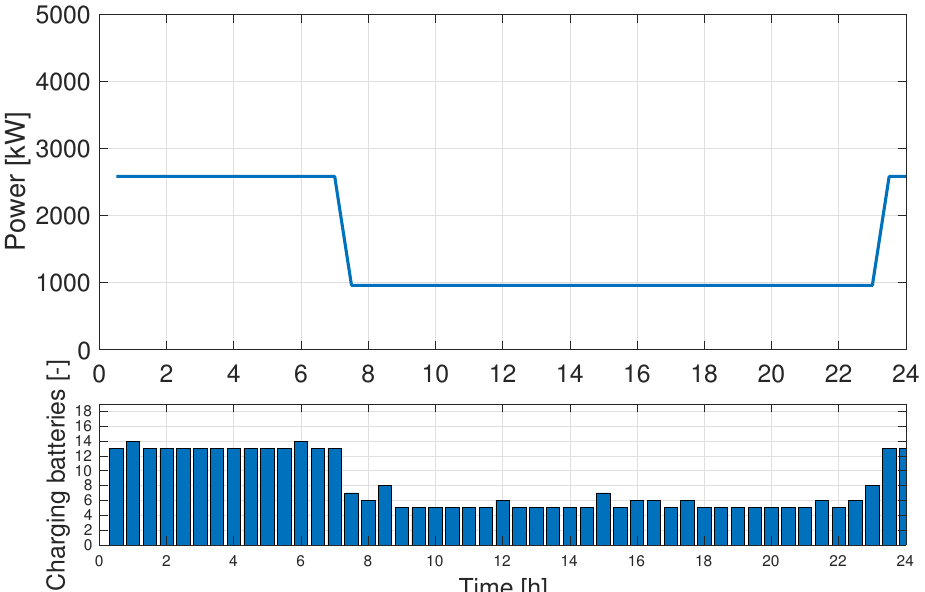
Figure 12. Power consumption (top) and battery charging schedule (bottom) at LGAV for the average day case (200 kW chargers).